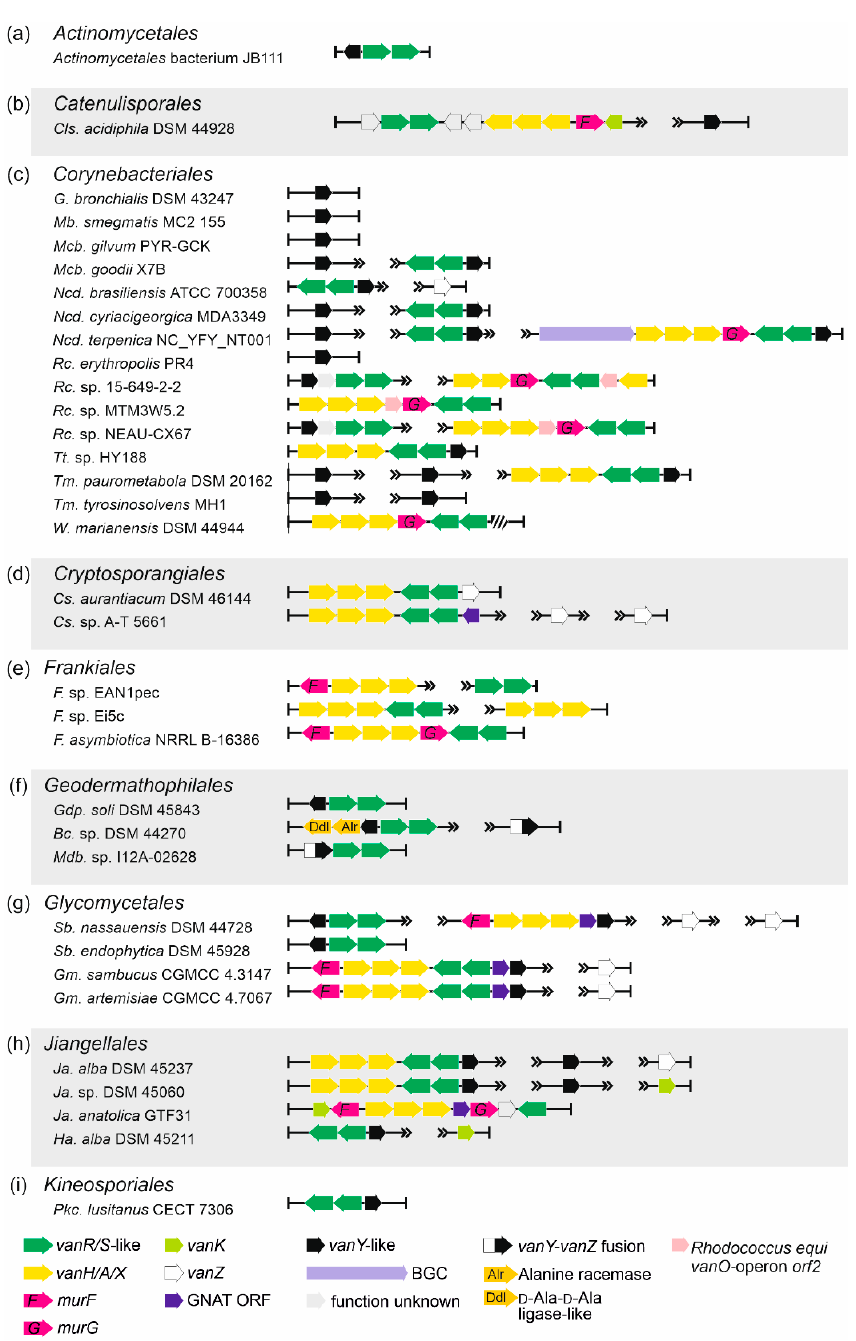
Figure 6. Arrangements of vlgs discovered in representative genomes from the orders ( a ) Actinomyc- etales , ( b ) Catenulisporales , ( c ) Corynebacteriales , ( d ) Cryptosporangiales , ( e ) Frankiales , ( f ) Geodermathophi- lales , ( g ) Glycomycetales , ( h ) Jiangellales and ( i ) Kineosporiales . Please refer to the main text for more details; genus names were abbreviated according to the ESM Table S1. The legend below the figure explains the color-coding of the scheme. Pseudogenes are